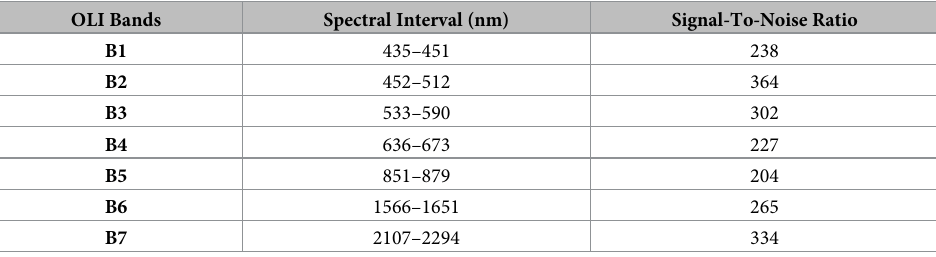
Table 1. Landsat-8/OLI configuration for each spectral band (Barsi et al., 2014). OLI Bands Spectral Interval